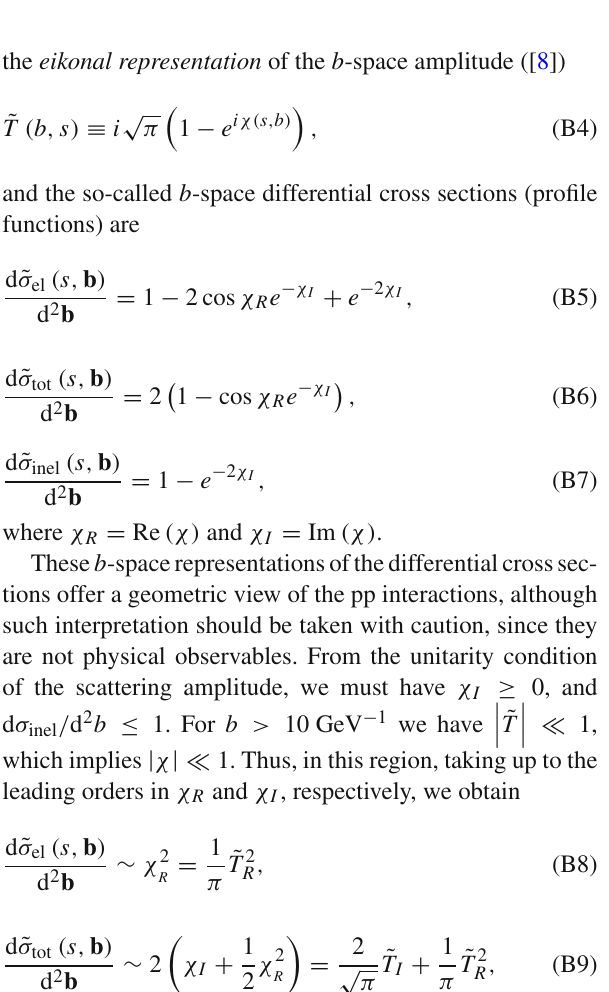
Fig. 9 b -space amplitudes at 8 TeV. Solid and dashed lines correspond to A8 and T8 measurements, respectively. As seen in the inset in the right-up corner, the real parts cross the imaginary parts around b ∼ 12 GeV − 1 and become dominant for the peripheral region. For 7TeV the structures are